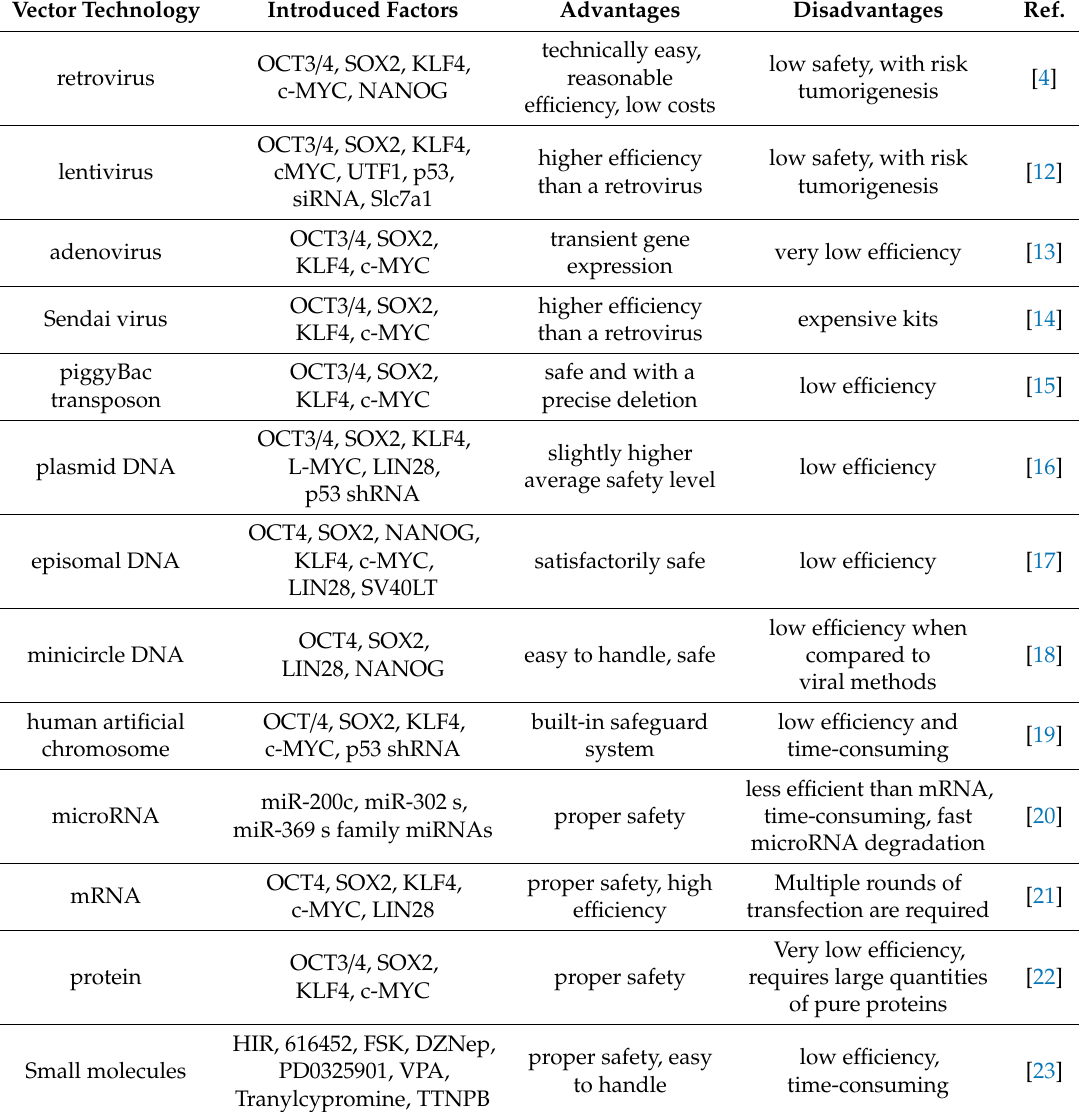
Table 1. Comparison of multiple reprogramming